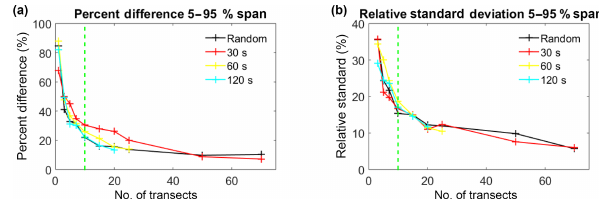
Figure 5. The 5–95% percent difference (a) between emission re- trieval and known simulation emission rate and (b) between rela- tive standard deviation (rsd) of the emission retrieval using various amounts of transects and random, 30s, 1min or 2min transect spac- ing. The recommended 10-transect criteria are shown in